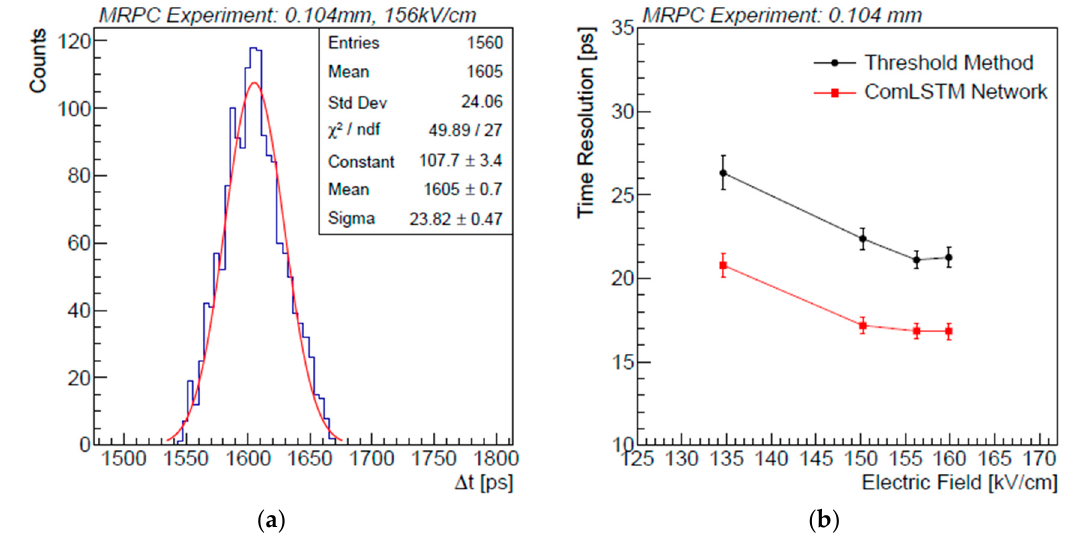
Figure 15. The time resolution results of the thin-gap MRPC Reproduced with permission from Wang et al., Journal of Instrumentation; published by IOP Publishing for Sissa Medialab, 2020 [97]. ( a ) Time distribution at E = 156 kV/cm for the ComLSTM neural network. The blue line shows the distribution of the time difference and the red line is obtained from the gaussian fitting. ( b ) Time resolution with the change of the working field. The black markers and curves show the results given by the threshold method, while the red markers and curves given by the ComLSTM.